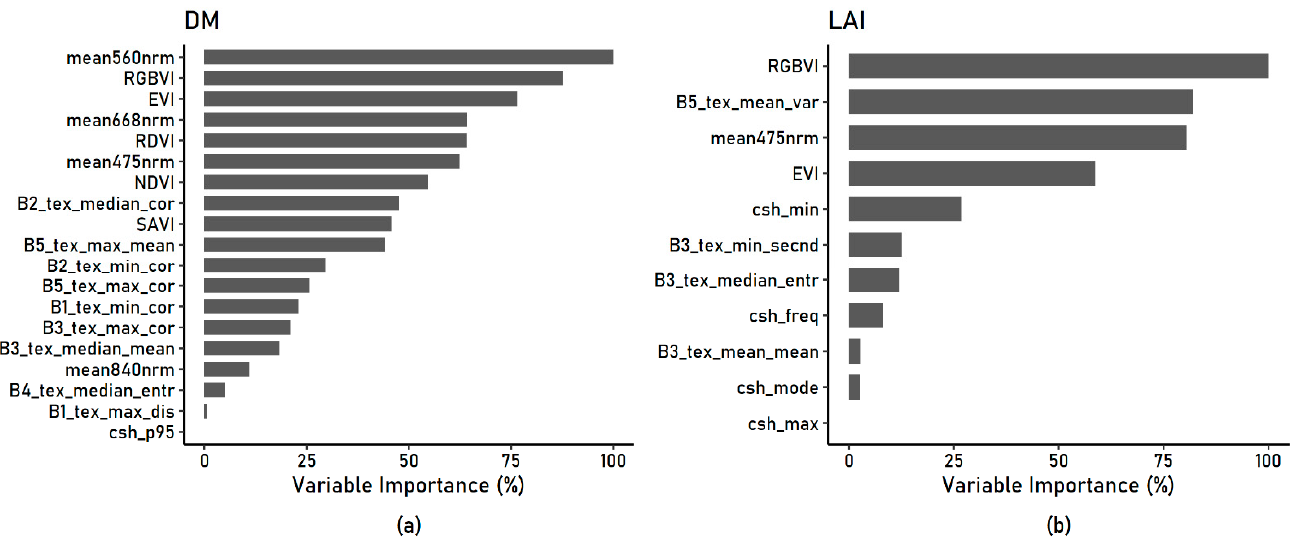
Figure 5. Variable importance of all variables selected by variable selection using random forests (VSURF) for ( a ) DM and ( b ) LAI prediction. Prediction is based on ( a ) normalized reflectance (e.g. “mean560nrm”), vegetation indices (e.g. “EVI”), texture variables (e.g. “B2_tex_median_cor”) and canopy surface height metrics (e.g. “csh_p95”).